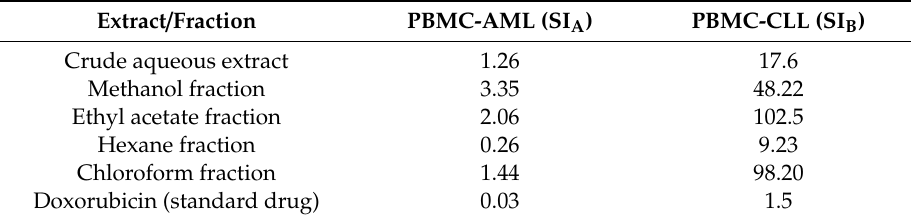
Table 7. Selectivity indices of tested crude aqueous extract, its fractions, and the standard drug. Extract /